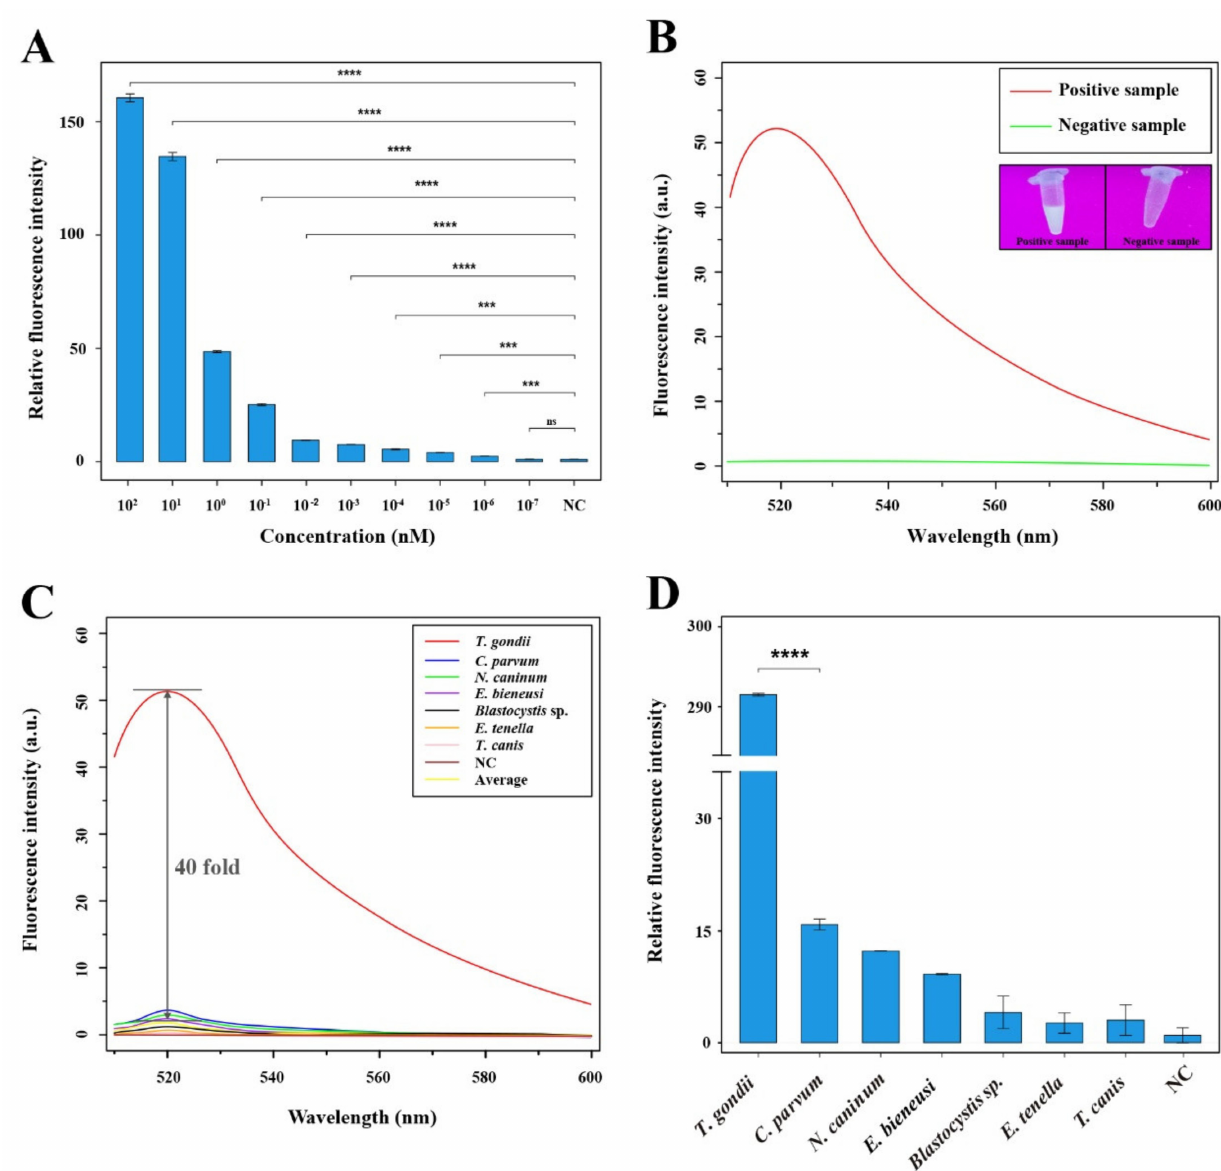
Figure 4. Analysis of specificity and sensitivity of the RAA-Cas12a-Tg system. ( A ) Sensitivity of the RAA-Cas12a system for T. gondii detection. Relative fluorescence intensity was estimated by the formula of (Ft-F0)/(Fn-F0) × 100%, where Ft, F0, and Fn represent the fluorescence peak values of the positive recombinant pMD18-T-529 bp plasmids after dilution by 10-fold serial ranging from 10 2 to 10 − 7 nM, blank, and negative control, respectively. Error bars represent the mean standard deviation (SD), where n = 2 replicates. **** p ≤ 0.0001; *** p ≤ 0.001; ns p > 0.05. ( B ) Visual detection of signal amplification by the naked eye under a UV transilluminator and by an observation of microplate reader of the positive sample containing T. gondii DNA and the negative sample without T. gondii DNA. ( C ) Specificity of the RAA-Cas12a system for T. gondii detection. The nucleic acids of other six parasites including C. parvum , N. caninum , E. bieneusi , Blastocystis sp., E. tenella and T. canis were used to evaluate the specificity of the RAA-Cas12a-Tg system. Average represents the largest fluorescence intensity of other six parasites at plateau phase; NC stands for negative control. ( D ) Specificity of the RAA-Cas12a system for T. gondii detection. The relative fluorescence intensity of T. gondii detection using the RAA-Cas12a-Tg system was more significant than that of the closely related C. parvum and other five parasites. Error bars represent the mean SD, where n = 2 replicates. **** p ≤